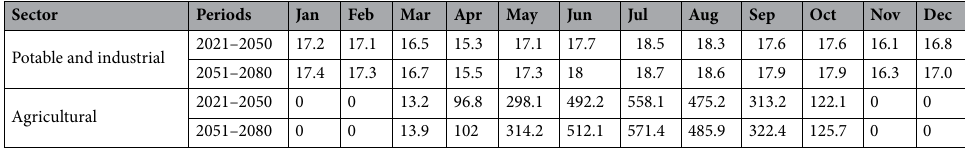
Table 5. Monthly potable, industrial, and agricultural water demands from the Bukan reservoir in the two future periods (10 6 m 3 ) (adopted from 22,23 ).